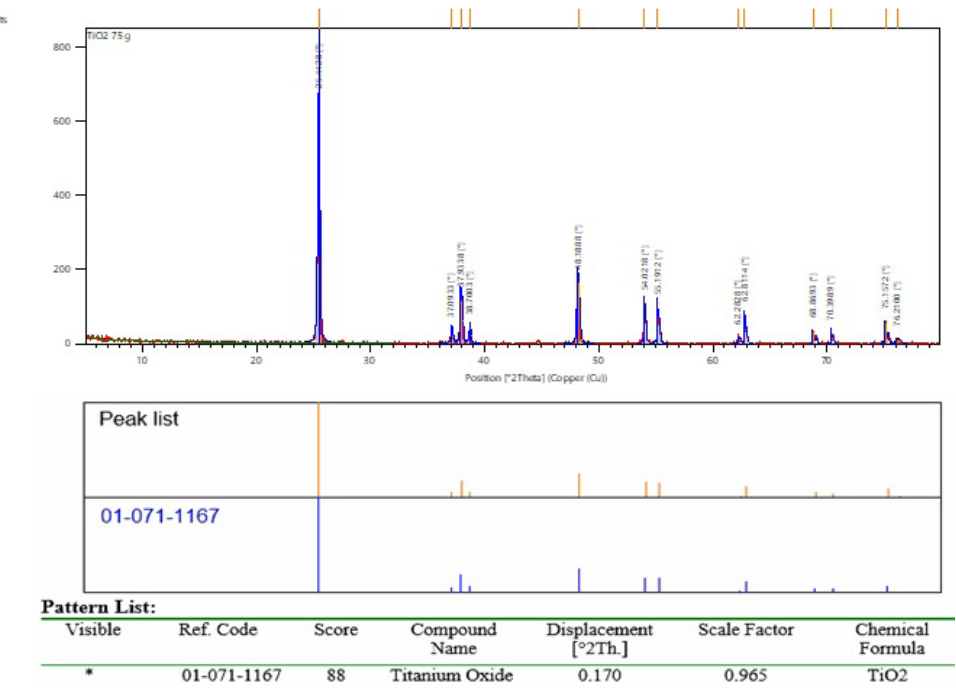
) used as a reinforcement in Cu-based 2